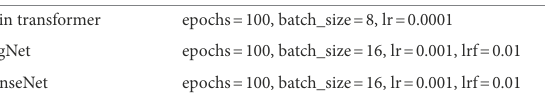
TABLE 2 Parameter settings. Model Parameter